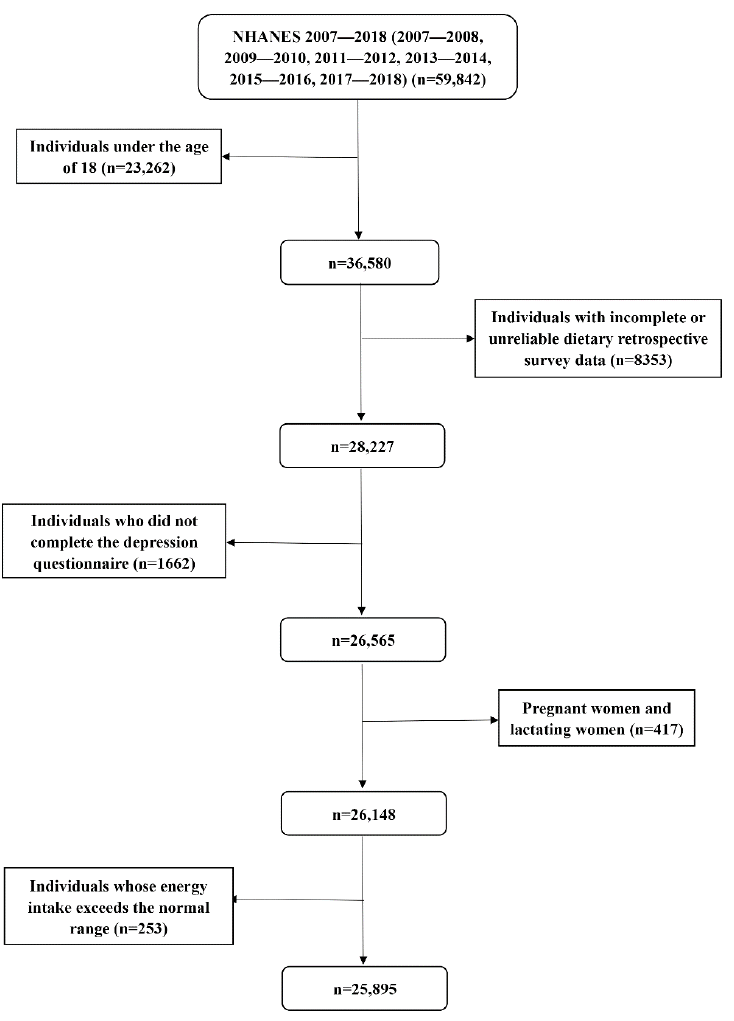
Figure 1. Flow chart of the screening process for the selection of eligible participants from NHANES 2007–2018.